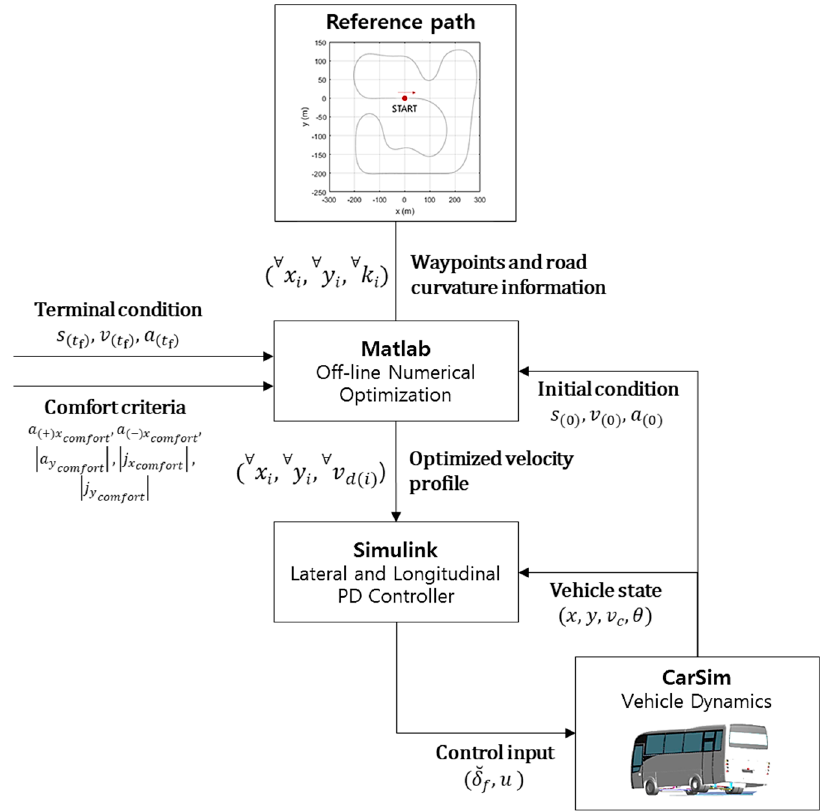
Figure 6. Software-in-the-loop (SIL) environment for a real-time vehicle dynamics simulation.